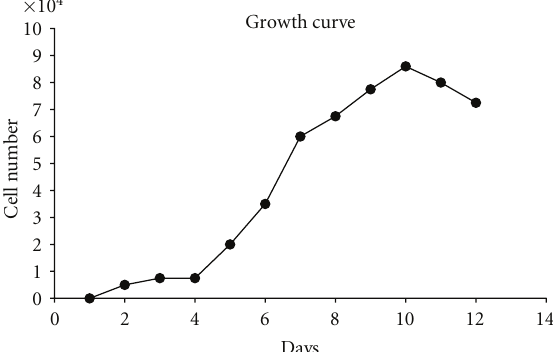
Figure 1: AFSCs growth curve and doubling time. AFSCs (5,000 cells/cm 2 ) were seeded and cultivated in 46-well plates for 12 days. At the end of each day, cells were washed, trypsinizated, and counted in hemocytometer. Each point refers to triplicate from two di ff erent AF samples. Cell doubling time calculated was 30 hours ( ± 4h).